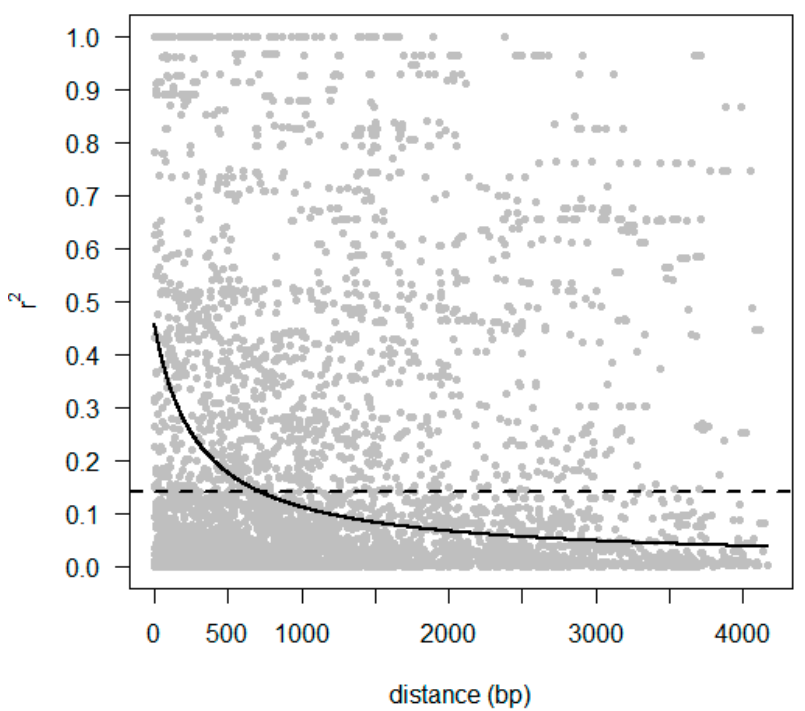
Figure 1. Pairwise LD ( r 2 ) values were plotted against the physical distance between all pairs of polymorphic sties (SNP/Indel) within the COBL gene. The trend line of the nonlinear regressions against physical distance is given by the solid line. The horizontal dotted line indicates the 95% percentile of the distribution of the unlinked r 2 , which gives the critical value of r 2 . The intersection point with the nonlinear regression curve, which determines LD decay, marks the threshold for the maximum physical distance between genetically linked markers.